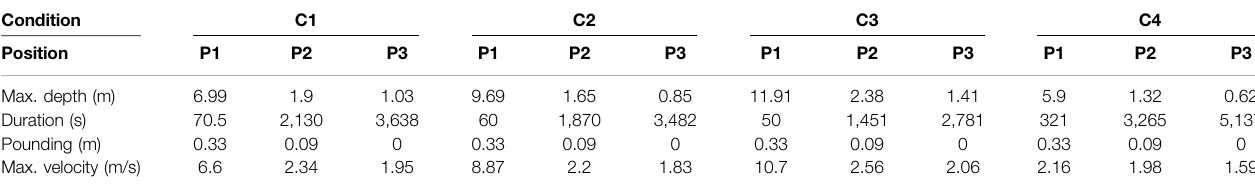
TABLE 4 | Key parameters in the fl ood routing progress.